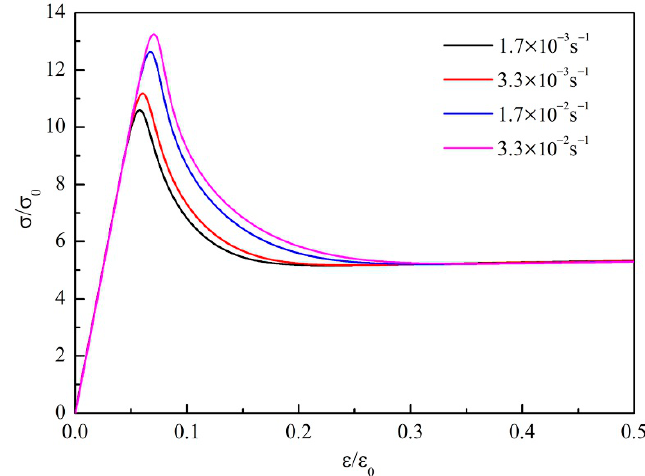
Figure 7. The relationship between σ / σ 0 and ε / ε 0 at a fixed temperature of 298 K and an initial system ( ∆ 0 = 0, Λ 0 = 0.5, ξ 0 = 0.05 and D ia = 0.01) under different strain rates.